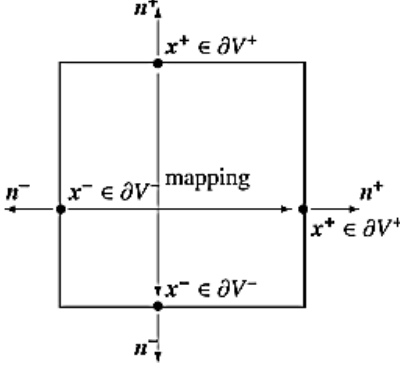
Figure 6. Periodic boundary conditions.